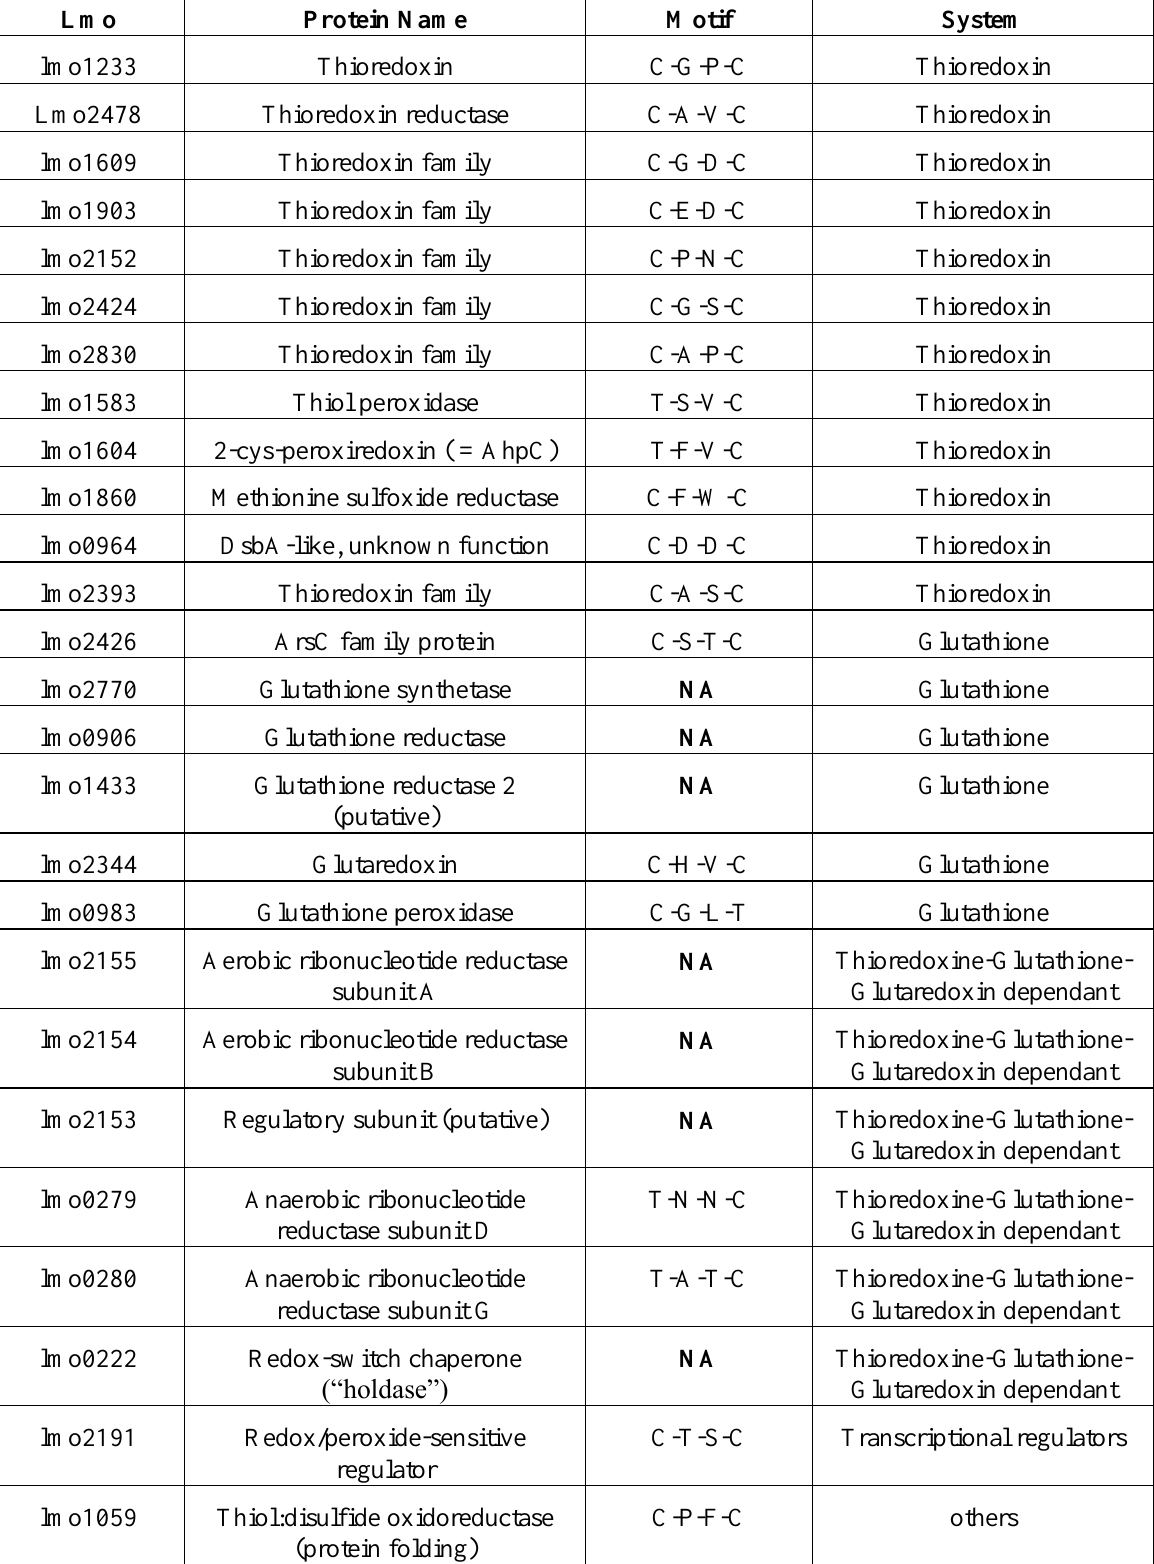
Table 1: Complete list of all 26 genes of TDRM